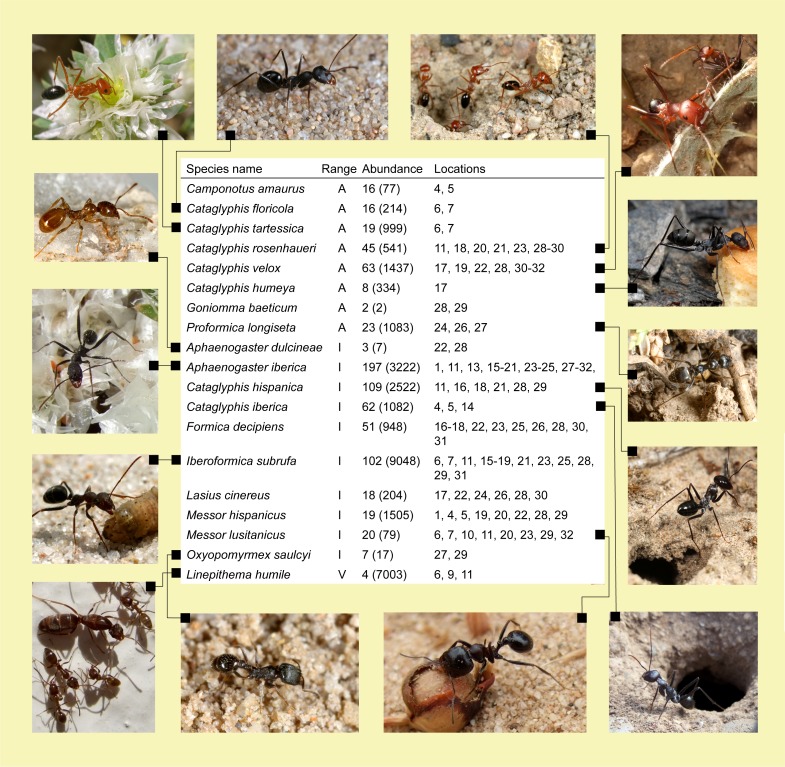
Endemic and invasive species found in protected areas of south Spain.The range of distribution is categorized in Iberian (I) or Andalusian (A) endemisms, or invasive species (V). The abundance corresponds to the number of plots with presence of each species from a total of 607, and in brackets is the total number of ants. Location numbers correspond to protected areas in Fig. 1.